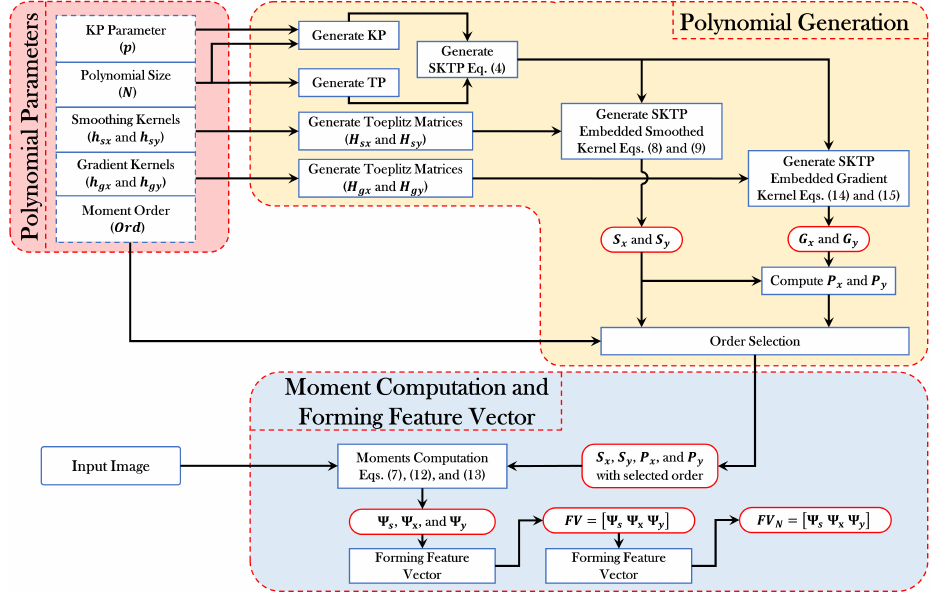
Figure 2. A flow chart of the feature extraction